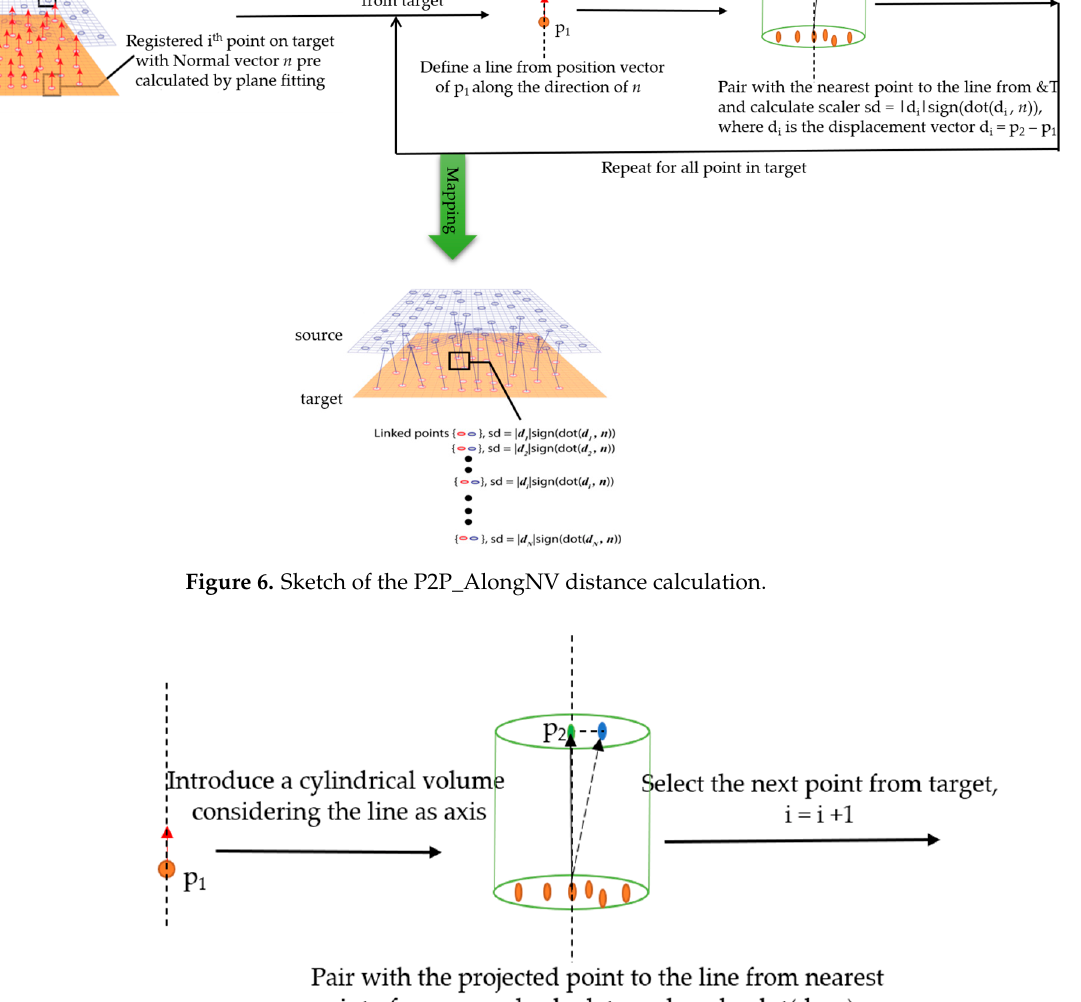
Figure 7. Sketch of the P2P_ProjectionAlongNV distance calculation.